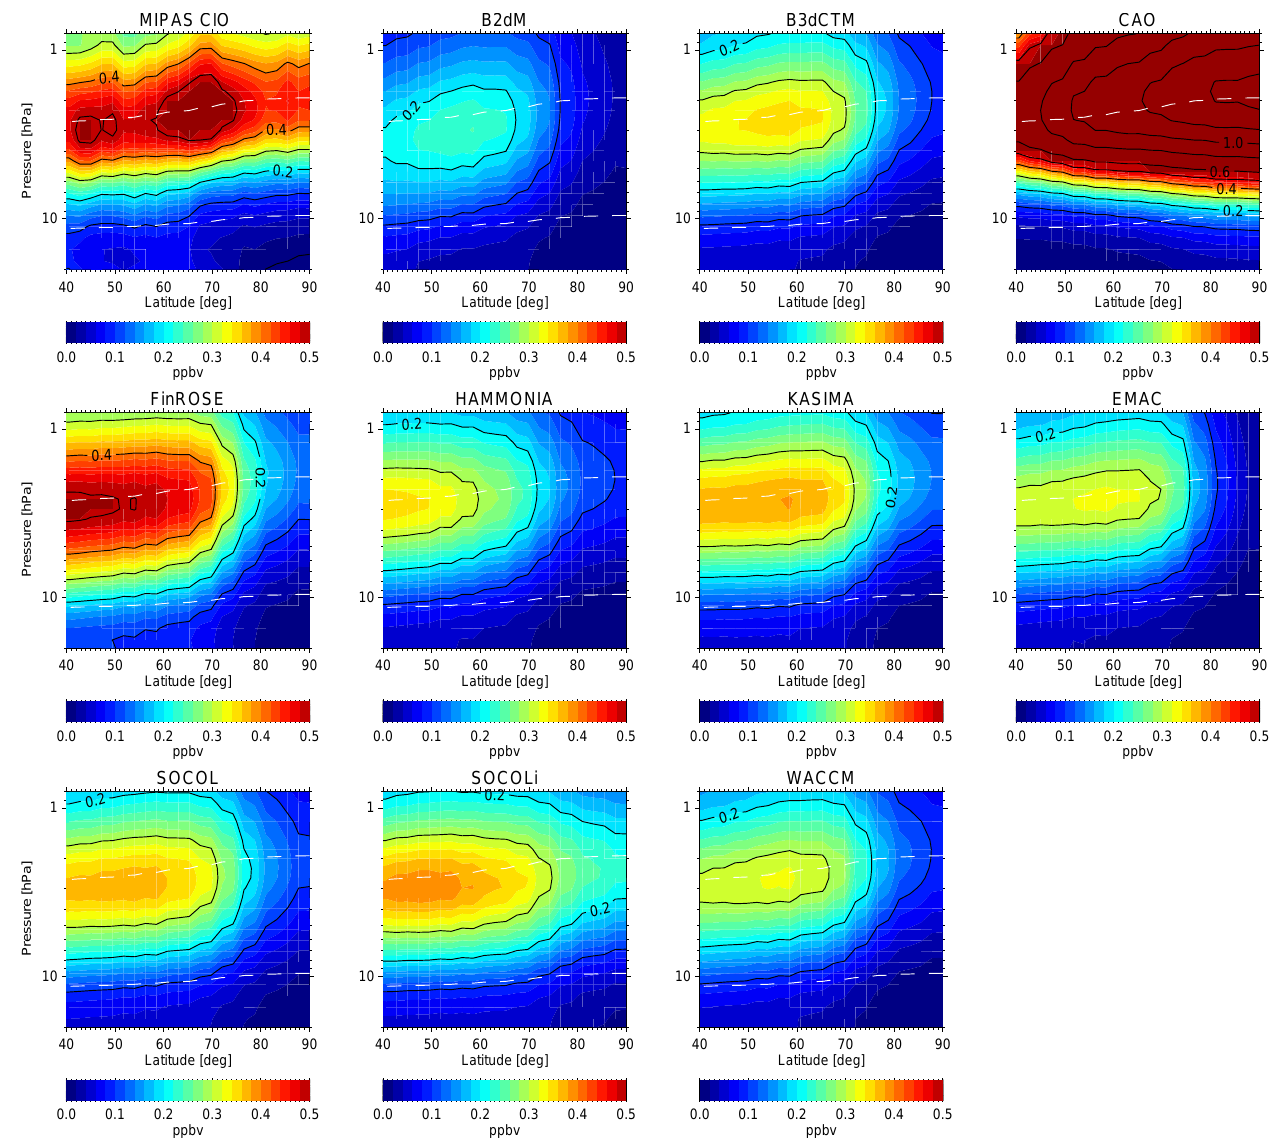
Fig. 33. Zonal mean ClO vmrs before the SPE 26–27 October in MIPAS observations and model simulations. Solid contour lines reflect 0.1 ppbv steps.